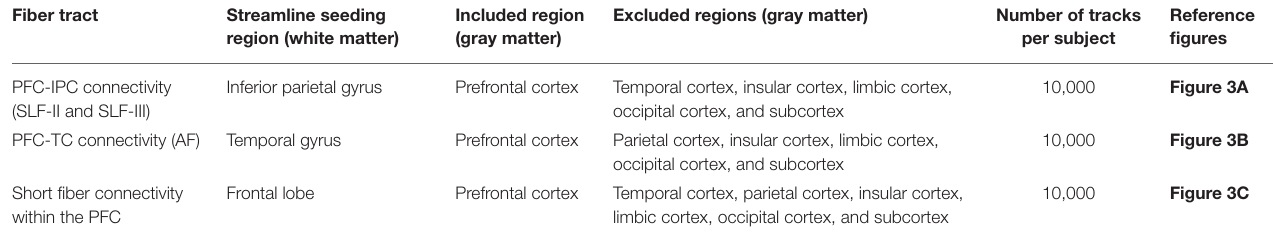
TABLE 2 | Guideline for reconstructing main fiber tracts.